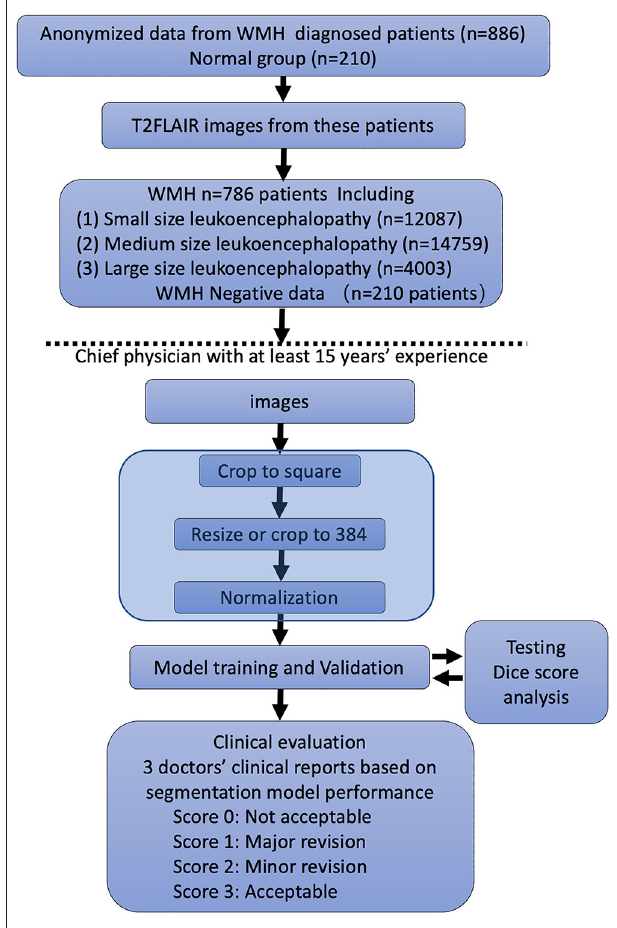
FIGURE 1 | Flowchart of the distribution of patients in the training and clinical evaluation steps. The distribution and classification of all samples in each step was used for the model training and clinical evaluation